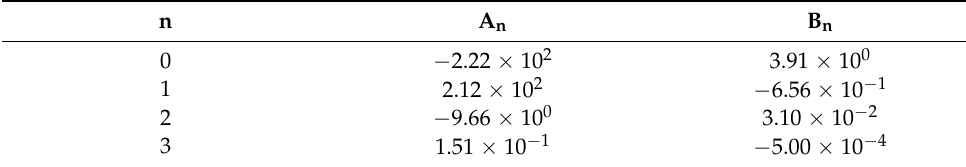
Table A24. Coefficients of the H 2 O-LiI density equation.